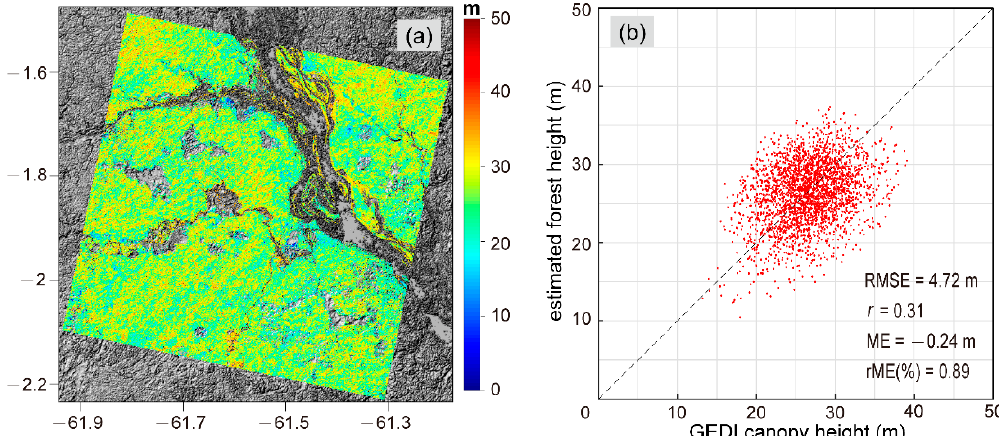
Figure 5. ( a ) The result of forest height inversion. ( b ) Validation plot of estimated forest height versus GEDI canopy height.